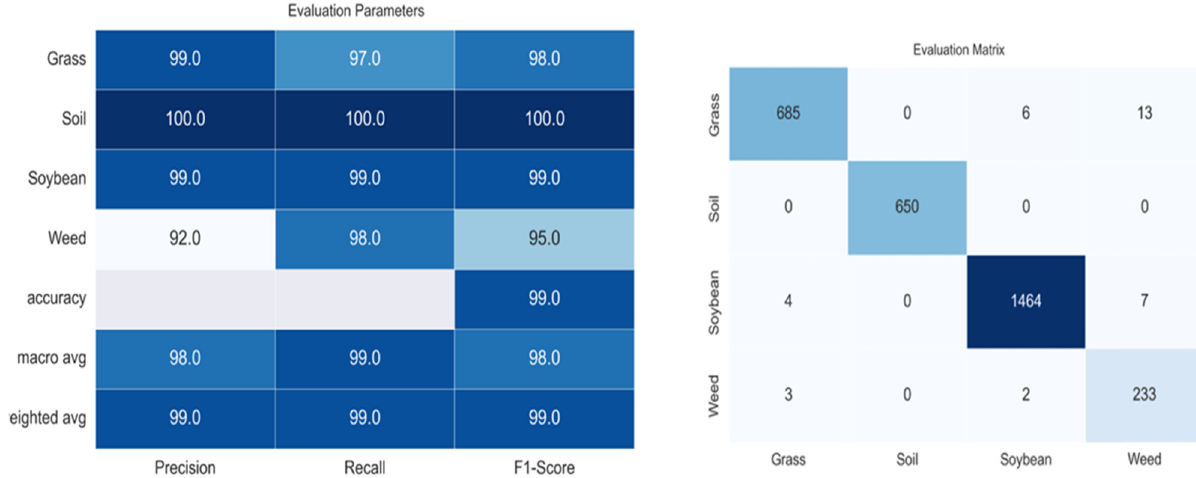
Figure 9: Testing on dehazed